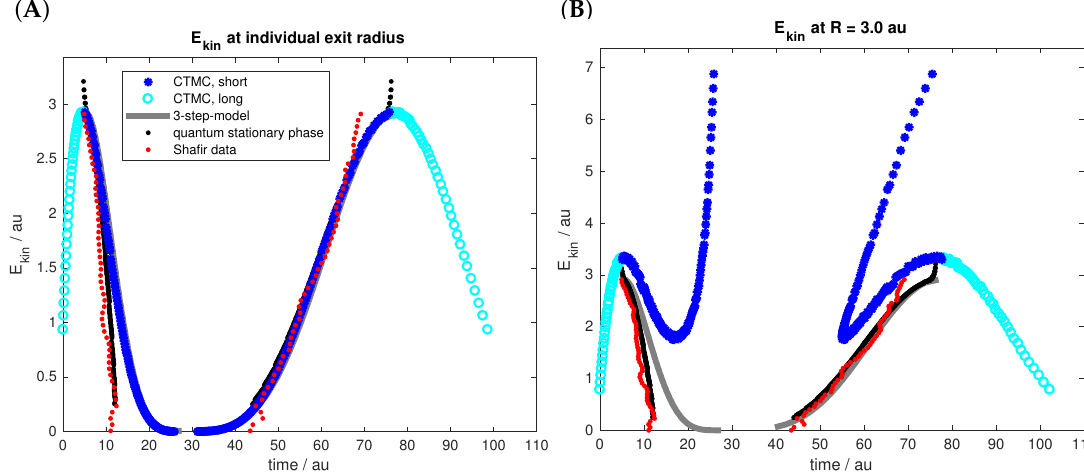
Figure 3. Kinetic energy of single classical trajectory calculations with Coulomb. ( A ) recorded at the exit radius for each trajectory; ( B ) recorded at a radius of 3 au from the parent ion. A fixed radius yields spurious energy for trajectories which are ionised late in the cycle, and low harmonics in the spectrum can not be recovered. Dark blue stars (light blue circles) represent short (long) trajectories, respectively. Red dots show the experimental data from Shafir et al. black the values from quantum stationary phase calculation [32] and grey the three-step-model [10]. Values for the last three provided from [18]. The values extracted from the Classical Trajectory Monte Carlo (CTMC) simulation in ( A ) reproduce the three-step-model so closely that the grey line is barely visible. The CTMC is of course based on this analytical model, except that it takes the Coulomb potential into account.